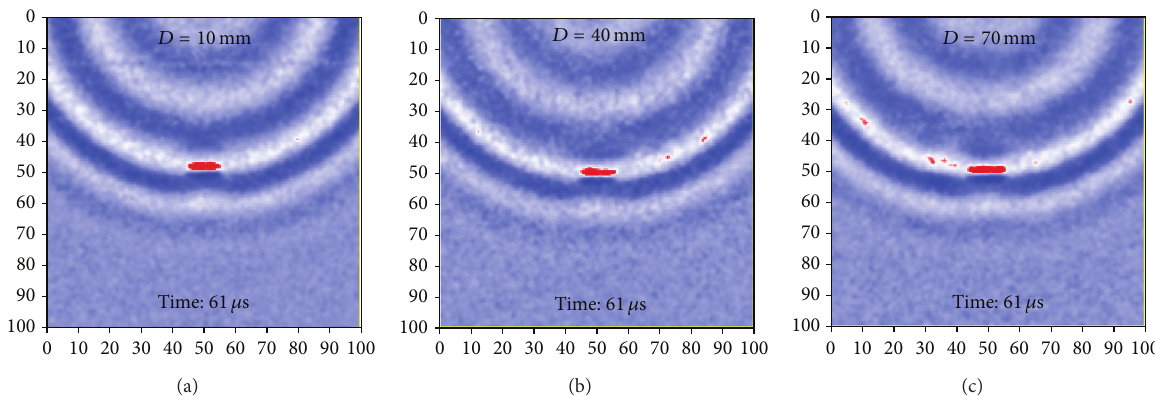
Figure 6: Ultrasonic wave fields at 61 𝜇 s in the water-immersed plate according to the water depth: (a) 𝐷 = 10 mm, (b) 40mm, and (c) 70 mm (the same color scale for (a) to (c)).